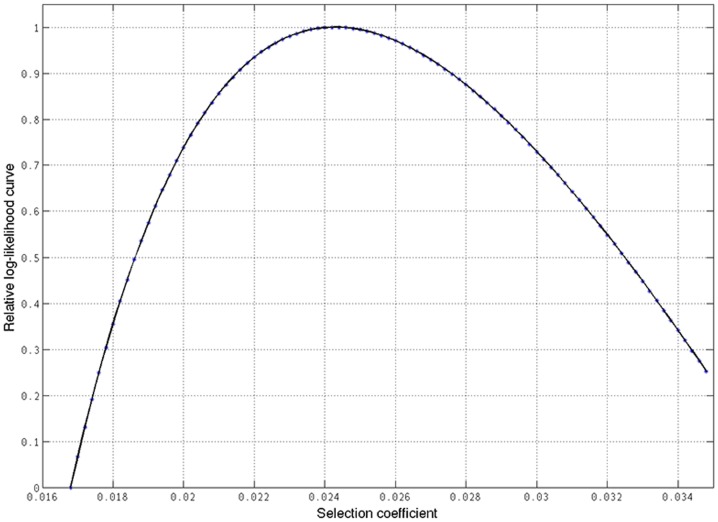
Estimation of selection coefficient (s) of allele 314F using the haplotipic data of 60 unrelated CEU individuals from the HapMap.The highest likelihood was obtained for s = 0.0243 (95% CI, 0.0111–0.0375).